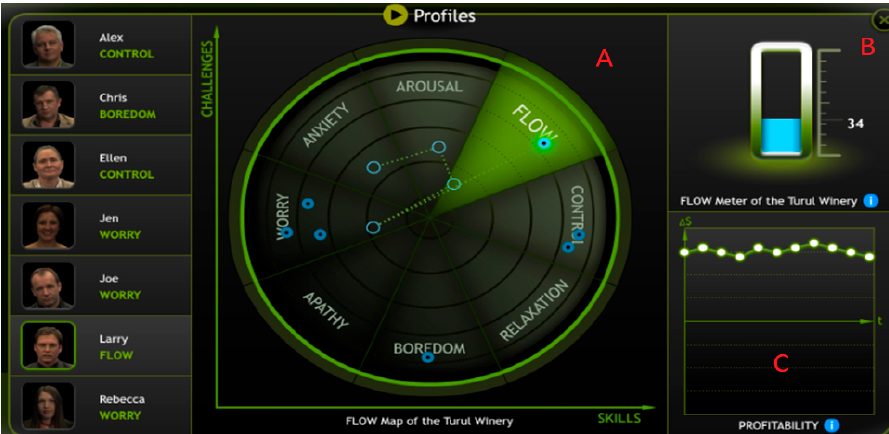
Figure 4. FLIGBY formative feedback (authors’ own illustration). ( A ) Flow Profile; ( B ) Flow Meter; and ( C ) Profitability Index.